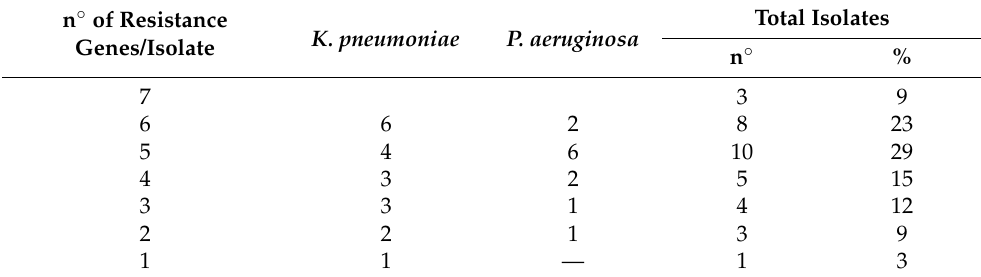
Table 2. Number of resistance genes carried per resistant isolate. n ◦ of Resistance Genes/Isolate K. pneumoniae